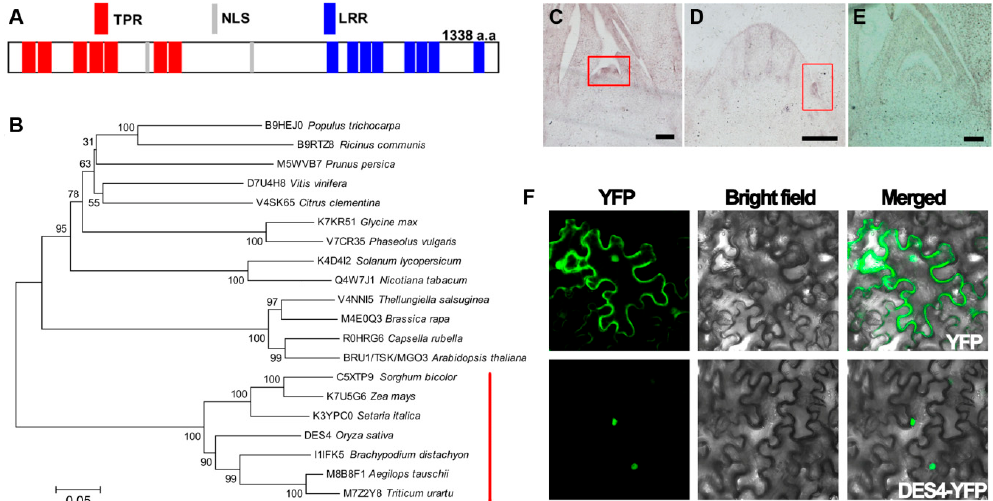
Figure 3. Protein structure, phylogenetic, and expression analysis of DES4. ( A ) Conserved domain analysis of the DES4 amino acid sequence. ( B ) Phylogenetic tree of DES4 and orthologs from other species. Numbers are the bootstrap values. Red line indicates the clade of grasses. ( C – E ) mRNA in situ hybridization analysis of DES4 in differentiating panicles meristems ( C ) and tiller meristems ( D ). Boxes highlight the tissue parts with strong expression signals. Bar = 10 μ m. ( E ) Negative control using sense probes. ( F ) Subcellular localization of DES4 in tobacco leaf epidermal cells.